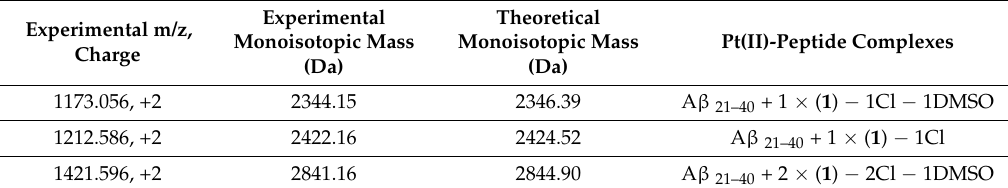
Figure 8. Electrospray ionization mass spectrometry (ESI) spectrum of A β 21–40 with 1 , after 24 h of incubation. All signals are generated from double charged ions. Table 3. Results of the ESI-MS analysis of the adducts formed by A β 21–40 and 1 . The experimental m/z values, the ion charge status, the experimental and theoretical monoisotopic mass values and the corresponding ion species are reported.